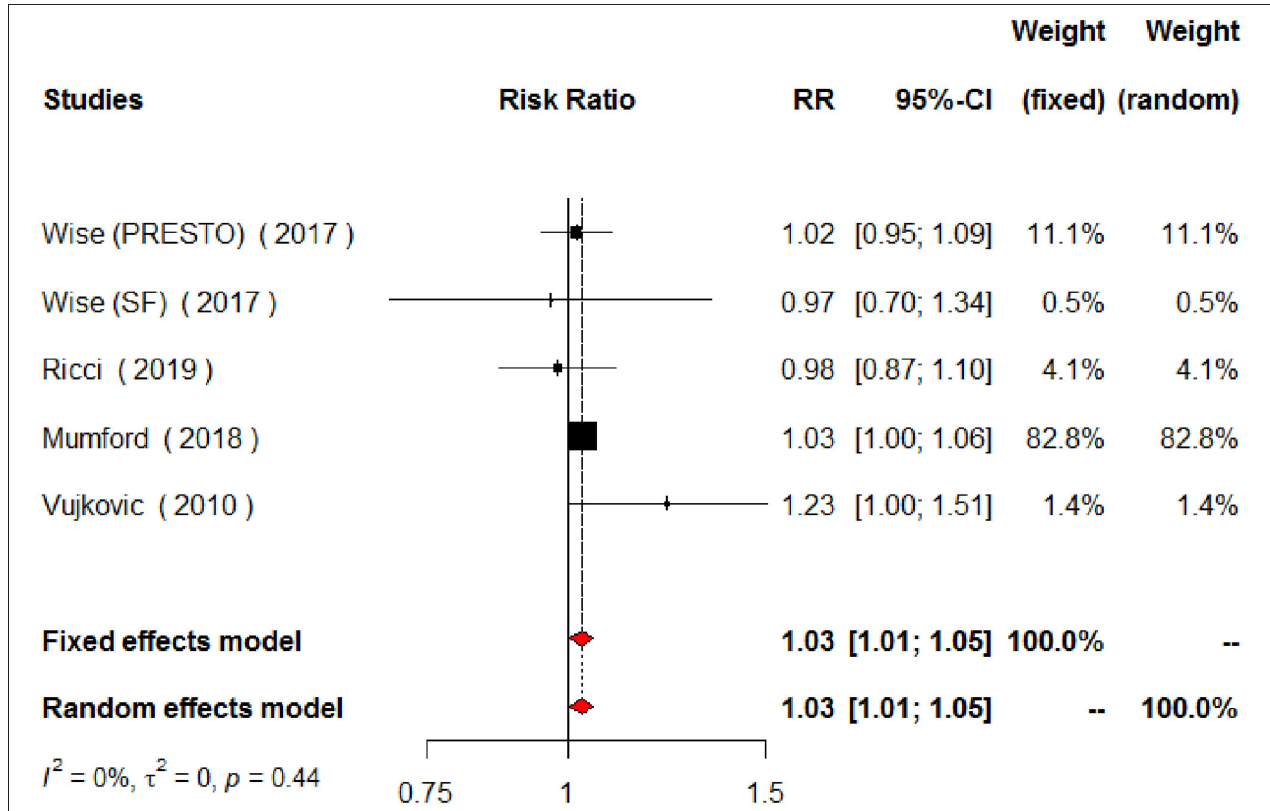
FIGURE 8 | Forest plot for the secondary meta-analysis of the relationship between periconceptional intake of MUFAs and pregnancy achievement ( n =